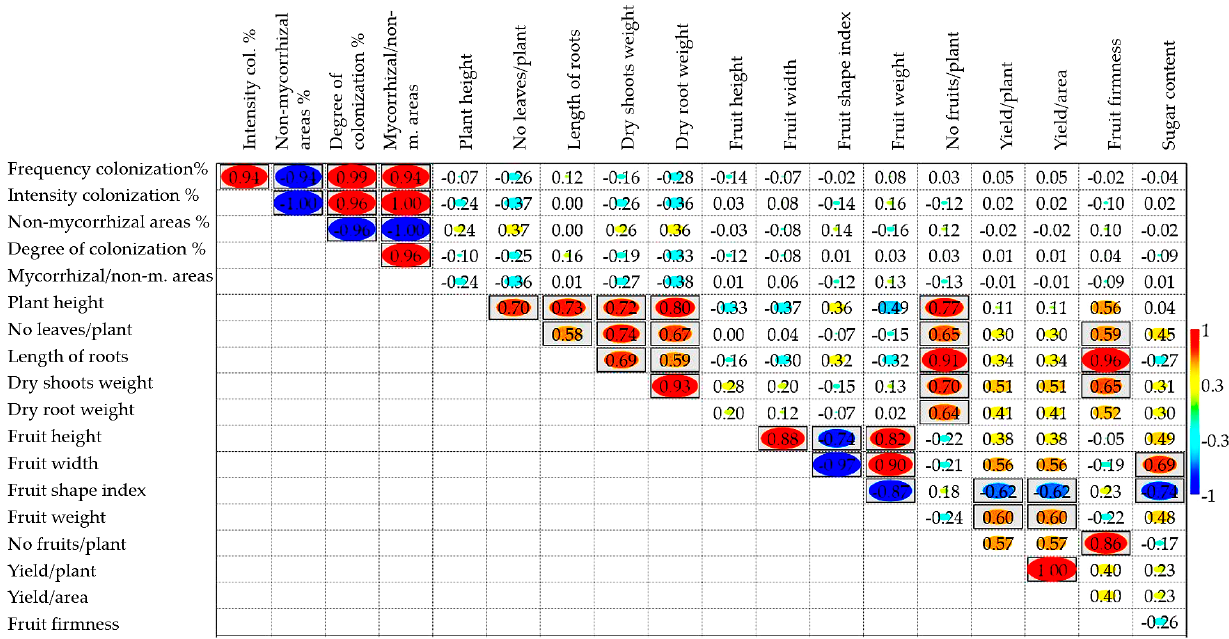
Figure 3. Phenotypic correlations between the pairs of traits analyzed. Correlations were calculated from mean values of the traits. Positive correlations are displayed in blue and negative correlations in red. Color intensity and the size of the circle are proportional to the correlation coefficients. The grey background boxes illustrate the significant values at the level of p < 0.05 (2-tailed).